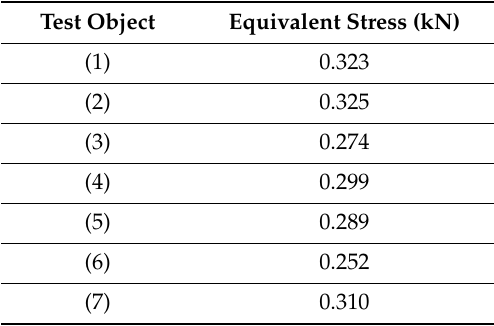
Figure 6. Icing thickness.